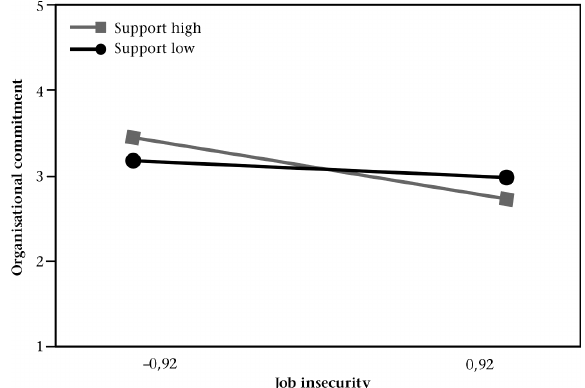
Figure 1: Organisational commitment as a function of perceived union support and job insecurity for the Italian sample